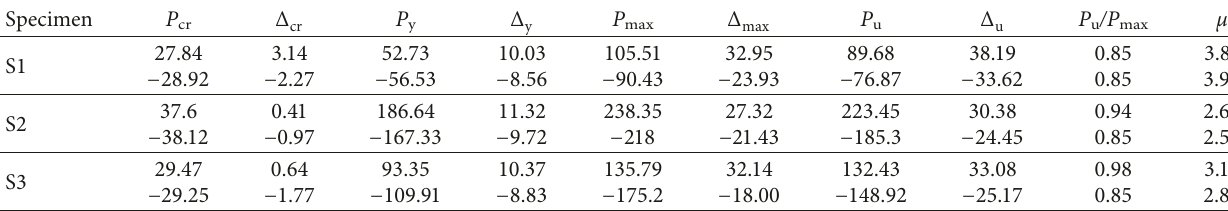
Table 2: Test results.